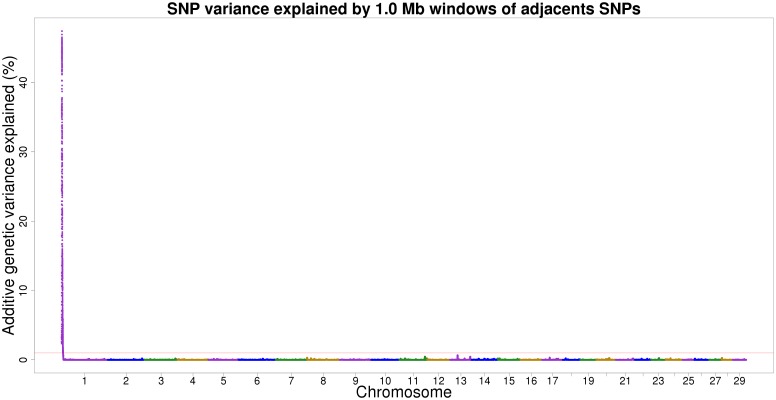
Proportion of additive genetic variance, explained by 1 Mb windows of adjacent SNPs, for the polled trait in Nelore cattle.